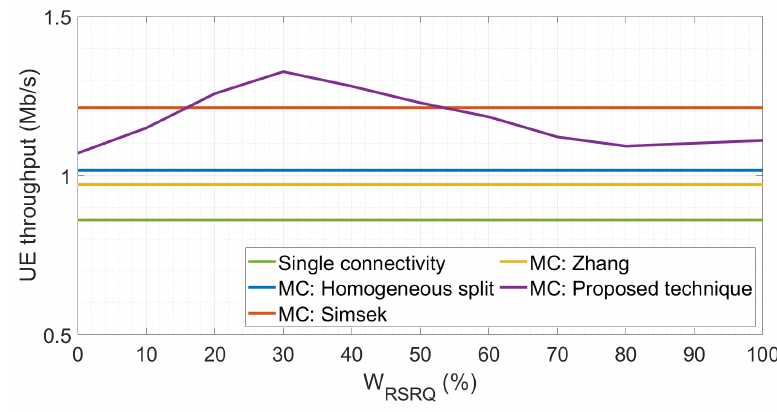
Figure 3. Median of the download throughput per